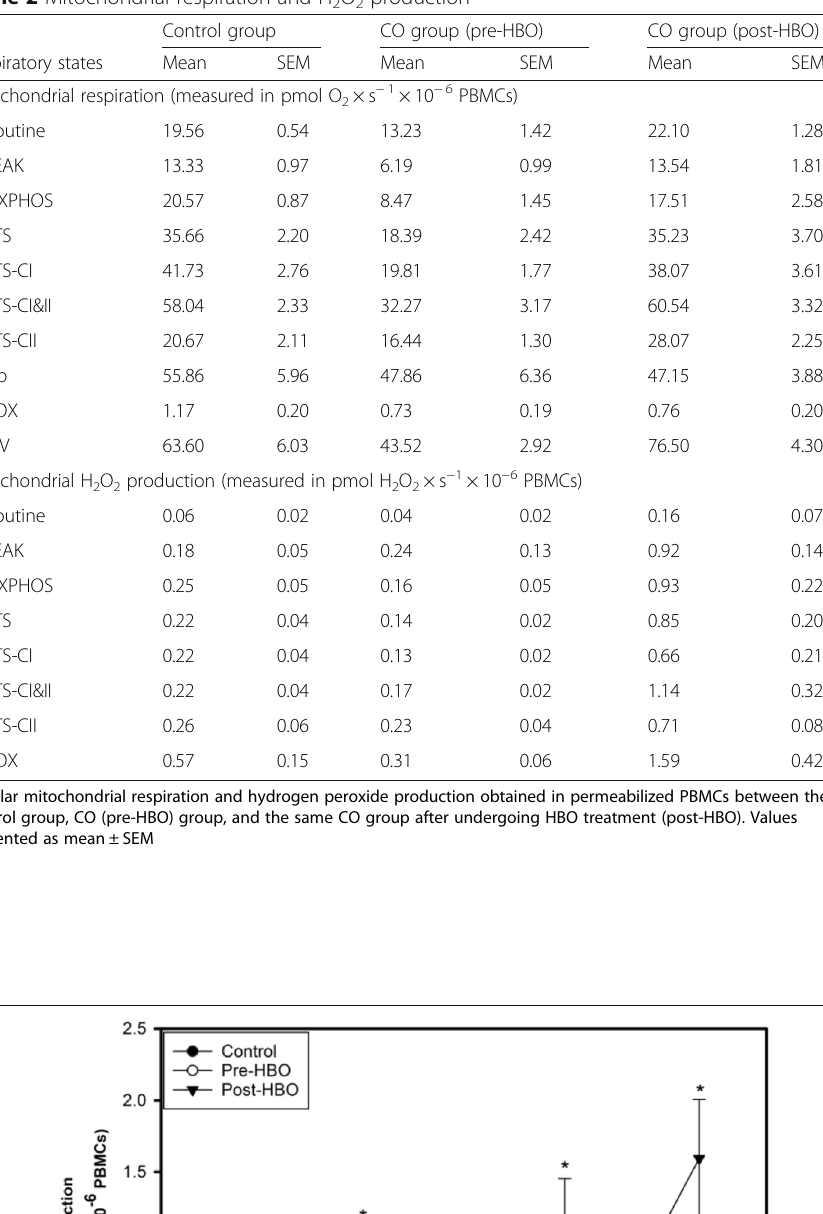
Table 2 Mitochondrial respiration and H 2 O 2 production